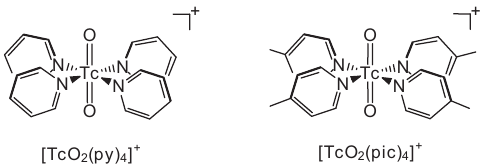
Figure 9 Representative trans -dioxo Tc(V) tetraimine